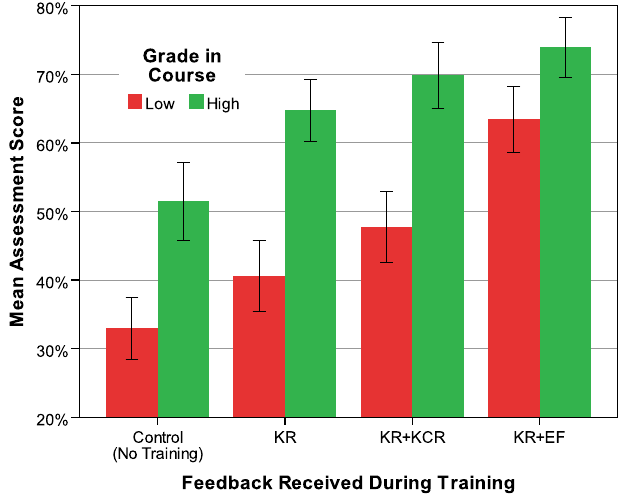
FIG. 4. Experiment 1 mean assessment scores for each condition, for students with high and low course grades.